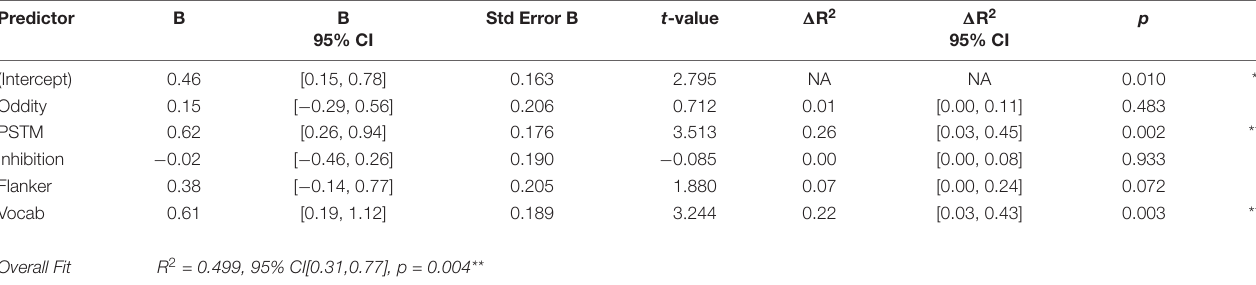
TABLE 4 | Summary of regression analysis for lexical decision, /tap-trill/ condition.